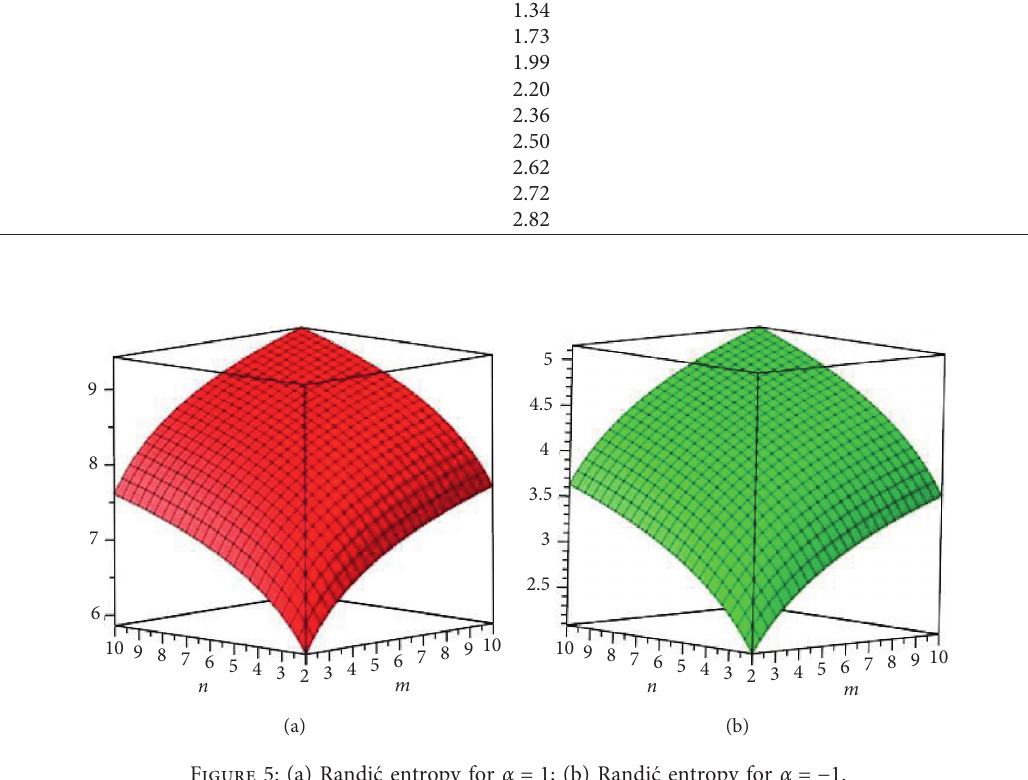
Table 11: Comparison of the ABC